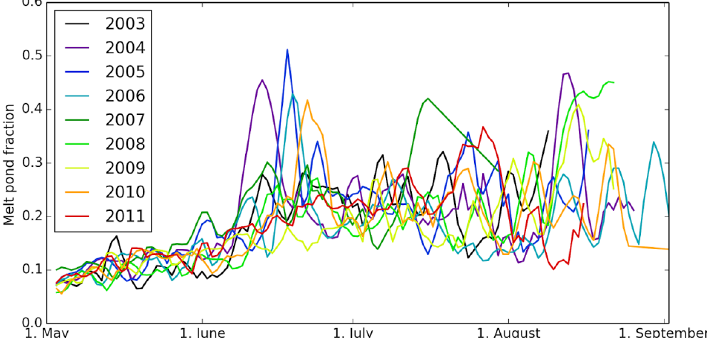
Figure 9. Time sequence of MPF for the studied years for the area of negative MPF trend in the East Siberian Sea (74 ◦ N, 160 ◦ E, marked with the red square “ES” in Fig. 1). In the 2nd–3rd week of June the MPF in the earlier years of the MERIS data set reached high (up to 0.5) peak values as the melt onset started, which is typical for the first year ice. In the later years, however, the behaviour of the MPF more resembles that of the MYI: no rapid melt onset, lower peak values of MPF. Running mean with window size 3 has been applied to the data.